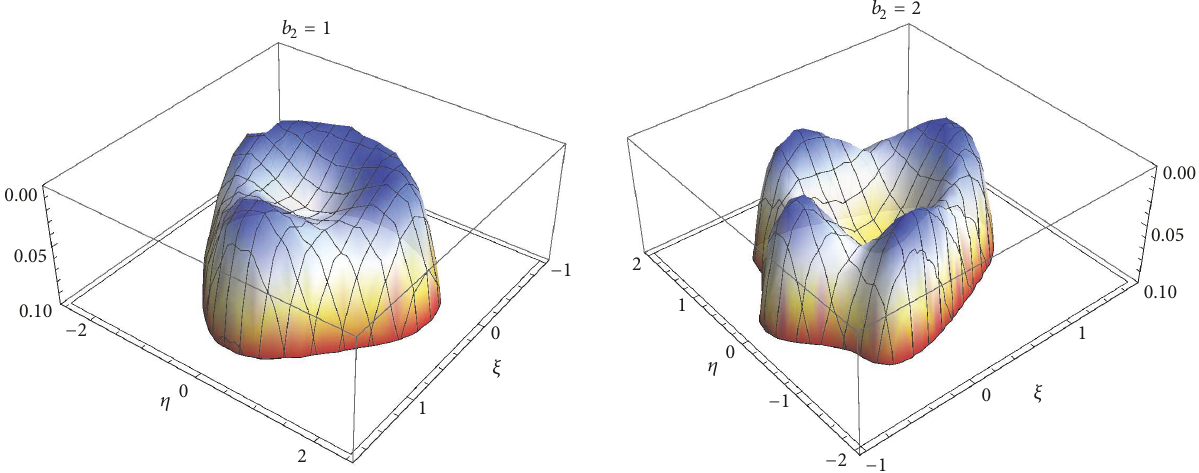
Figure 4: These graphics unveil upside down views of 𝑉(𝜉, 𝜂) , with 𝑏 2 = 1 (left panel) and 𝑏 2 = 2 (right